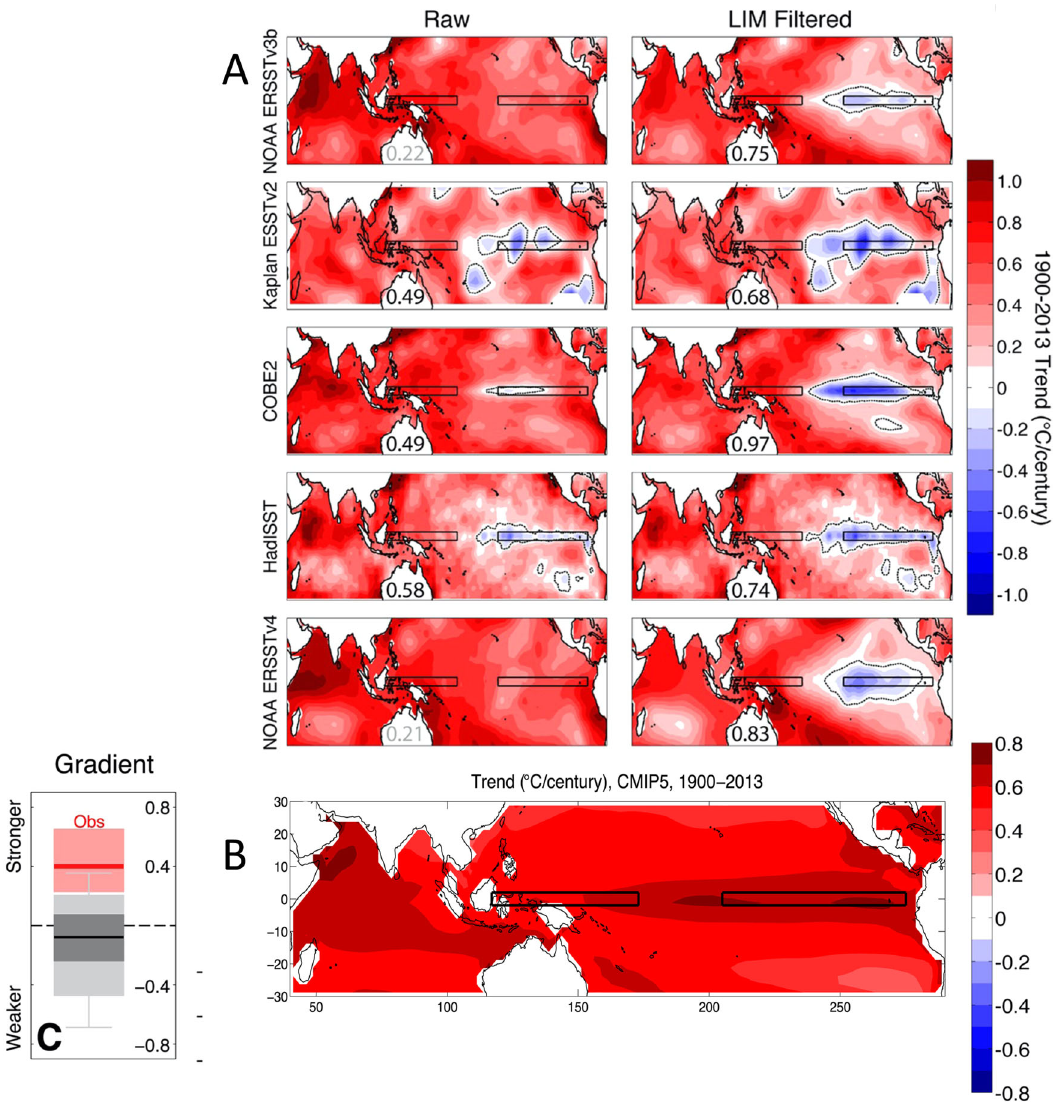
Fig. 1 SST trend (°C [100 yr]-1) from 1900-2013. A observation-based data and ( B ) 83 CMIP5 simulations from 41 models with historical radiative forcing; RCP future projection values are used after 2005. In ( A ), the SST reconstructions used for each panel are indicated on the y axis. Also in ( A ), the left column shows the un fi ltered trend and the right column shows the trend with linear El Niño-Southern Oscillation dynamics removed using an optimal perturbation fi lter 199 . The numbers in ( A ) are the values of the trend in the SST difference between the two boxes, one over the western tropical Paci fi c, and the other over the eastern tropical Paci fi c. The range of the CMIP5 trends ( o C/century) is shown in ( C ). These plots are adapted from ref. 23 which provides additional information on the data